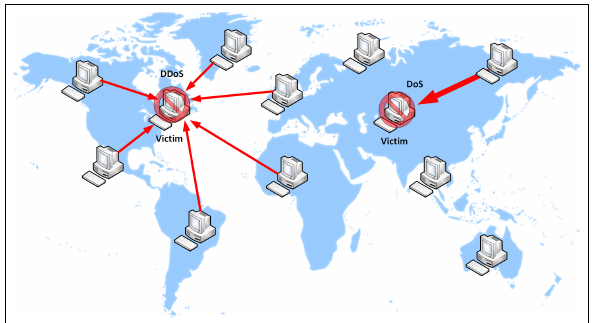
Figure 1. DoS vs